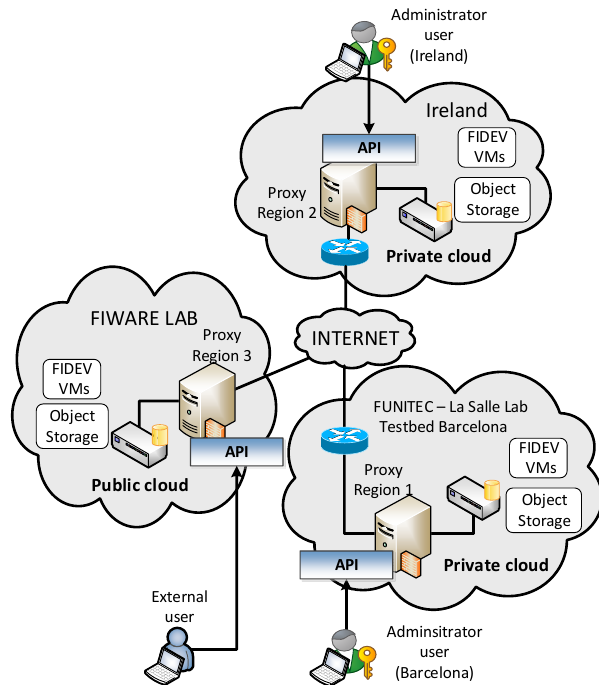
Figure 4. Test environment built on the FINESCE project facilities. There are three physical locations with three FIDEVs (FInesce DEVices) hosted at each location. The proposed HCDM Application Programming Interface (API) under evaluation is running at all FIDEVs. Each FIDEV is in charge of ten smart meters.